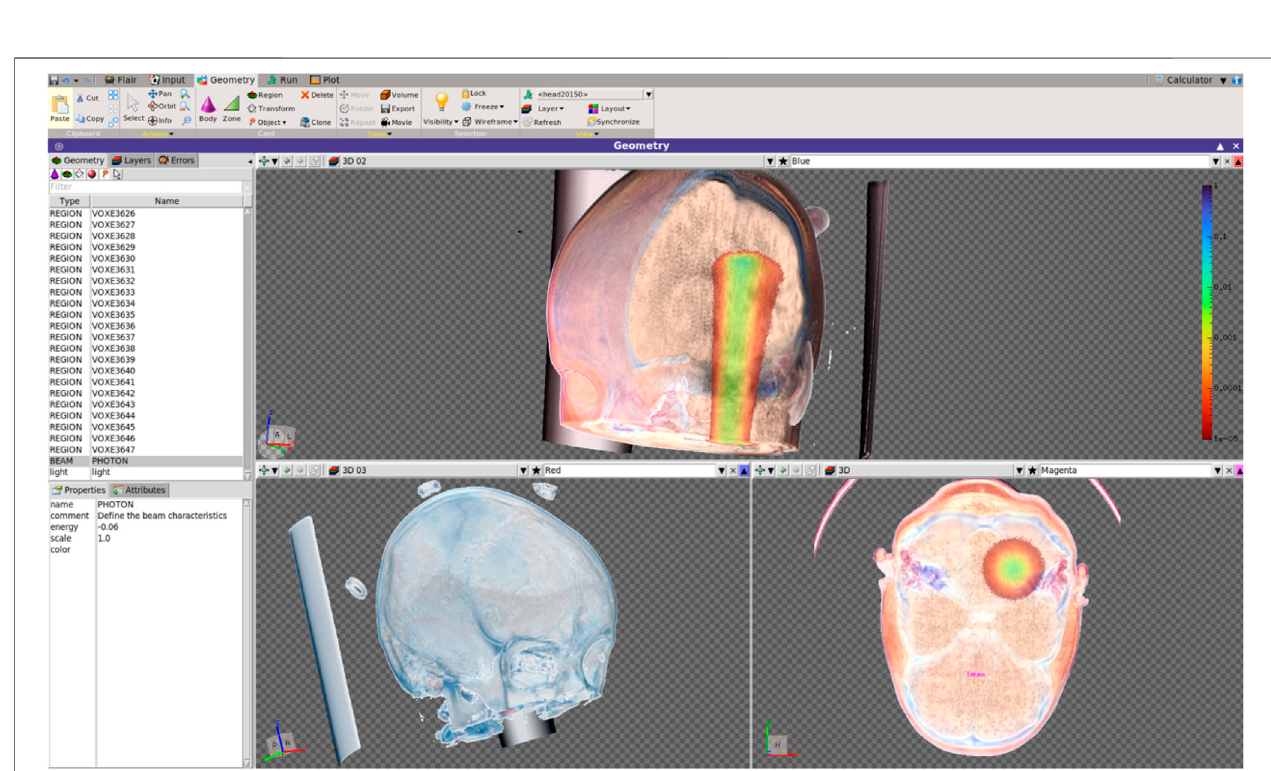
FIGURE 8 | Volumetric visualization of a voxelized phantom and dose distribution from a photon beam irradiation with the new renderer available in Flair v3.